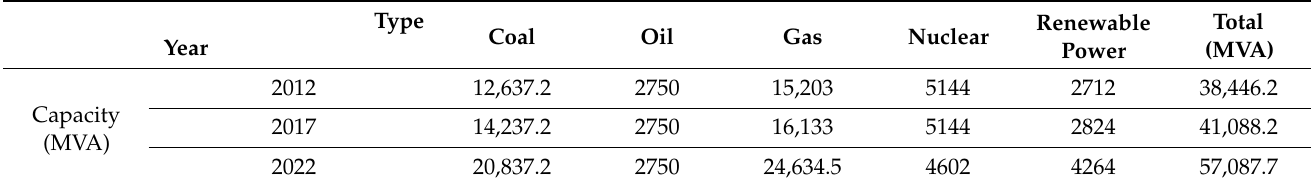
Table 1. The capacity of different generation types in the TPC system.